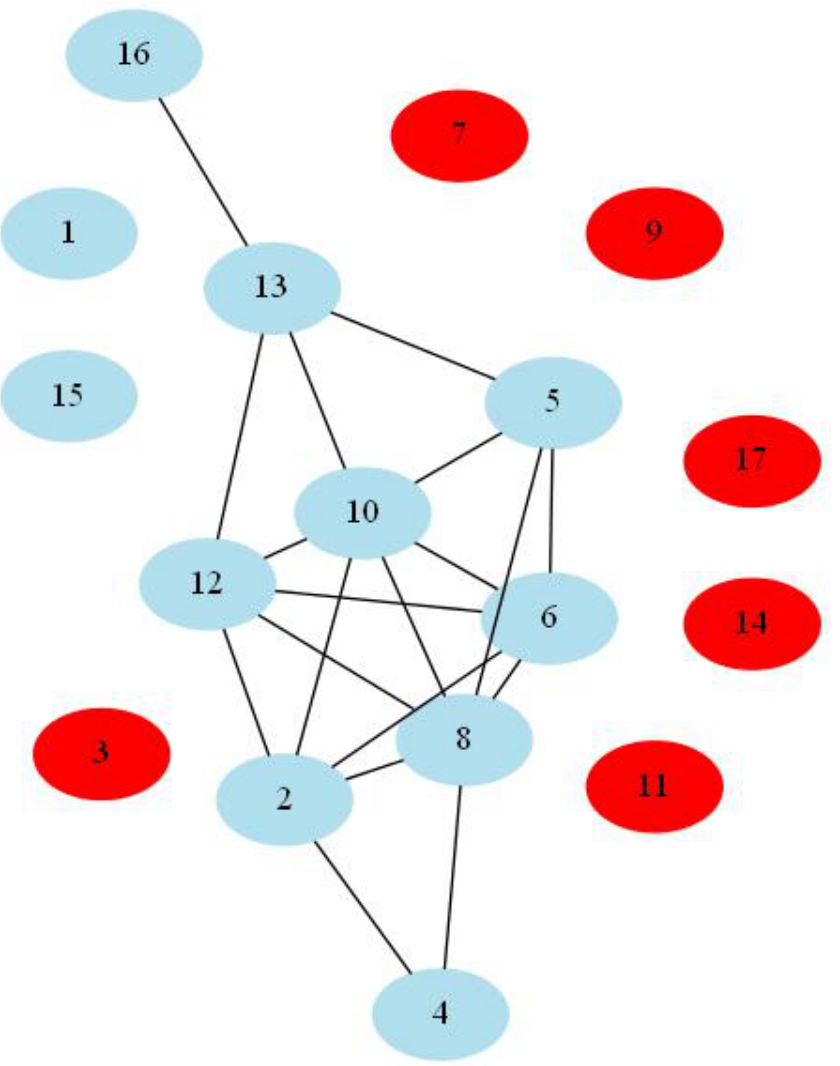
Figure 8: Graph visualization of the book chapters using the NCD distance computed with the LZMA compressor. Again, for convenience, the Profane storyline chapters are depicted in blue, and the V. storyline chapters in